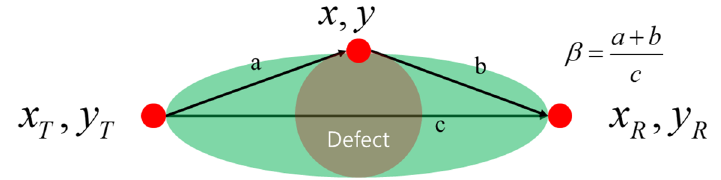
Figure 2. Fundamentals of the shape function.